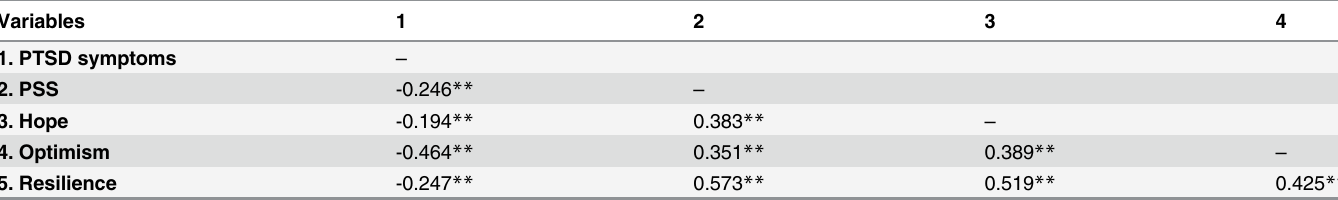
Table 3. Correlations among PTSD symptoms, PSS, hope, optimism and resilience. Variables